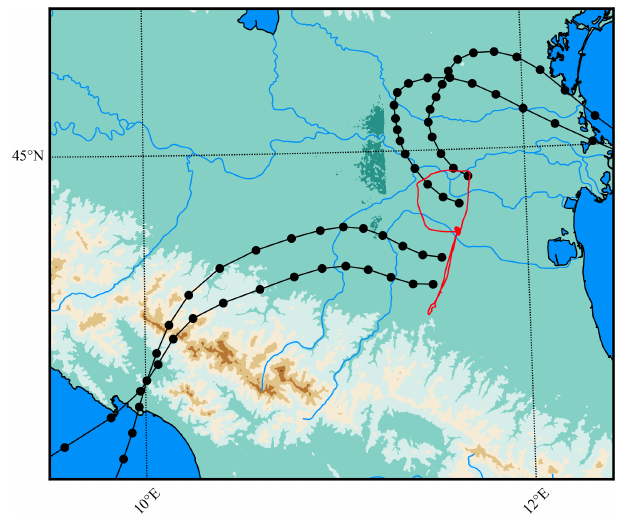
Figure 9. Air mass back-trajectories (black dotted lines) arriving to the Zeppelin’s measurement area at 08:00UTC (when the NPF event started) over northern Italy on 30 June 2012. The arrival al- titude of the trajectories is 400ma.s.l. The separation between the dots along the trajectories is 1h. The red line is the Zeppelin’s flight